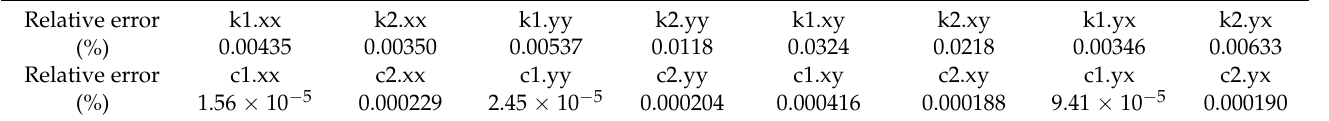
Table 11. The biggest relative identification error using h1.1.